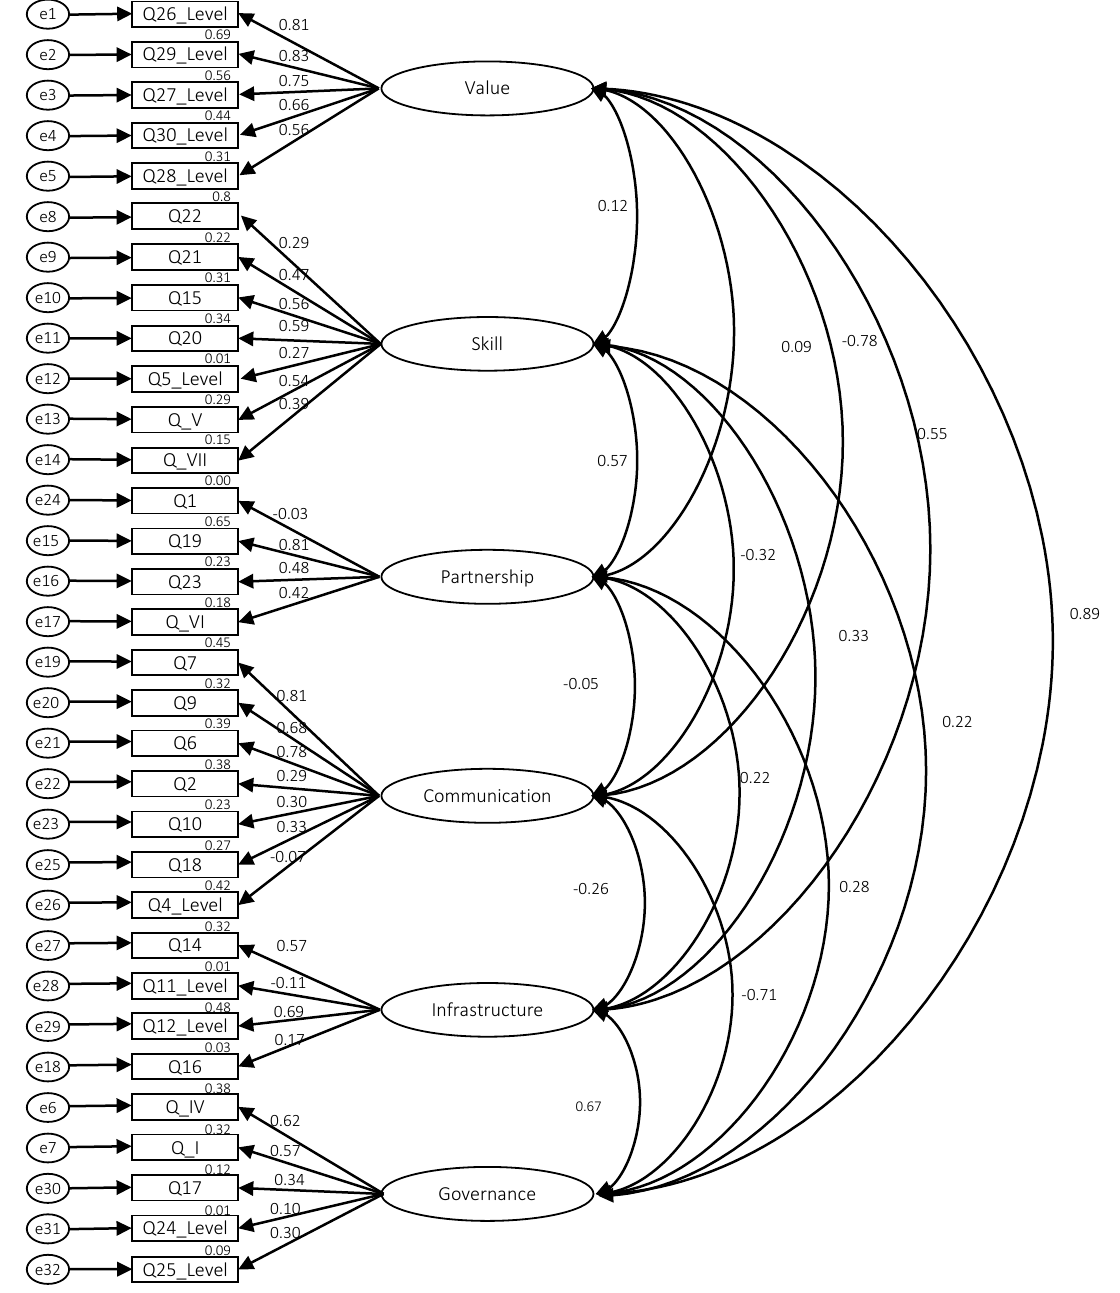
Figure 1. Factor analysis model to illustrate SMEs communication strategies vis-a-vis their BITA _ (see each construct assigned coding and variable labels in